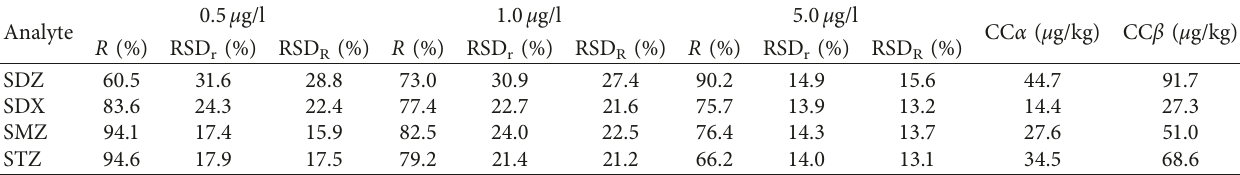
Table 4: Validation parameters of the model study at three concentration levels ( n � 12).